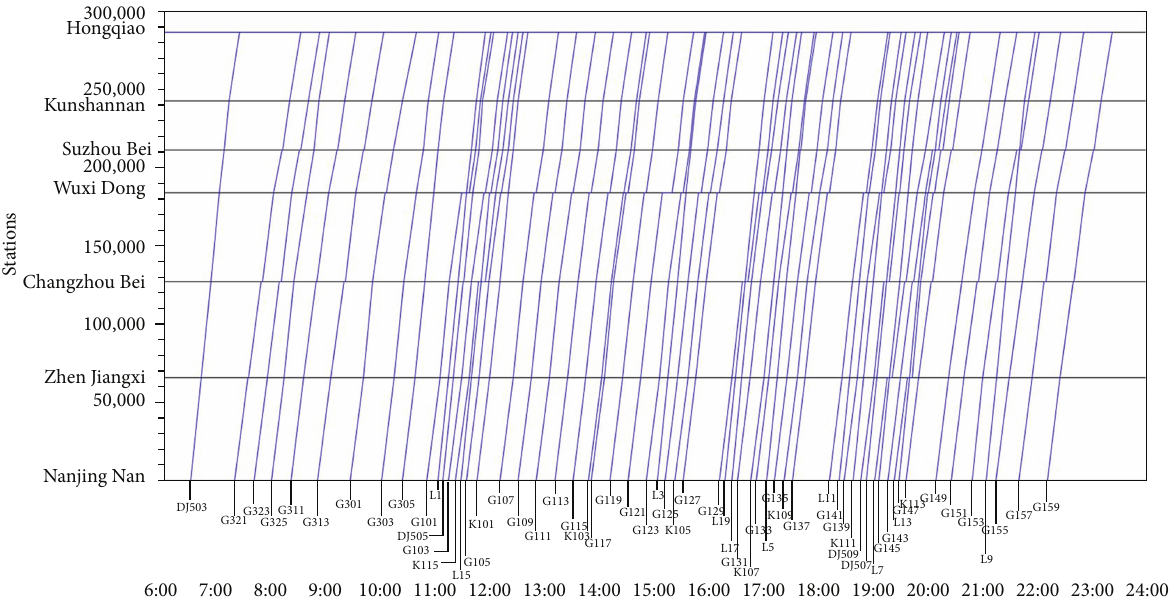
Figure 4: The planned timetable of Hu-Ning Part.